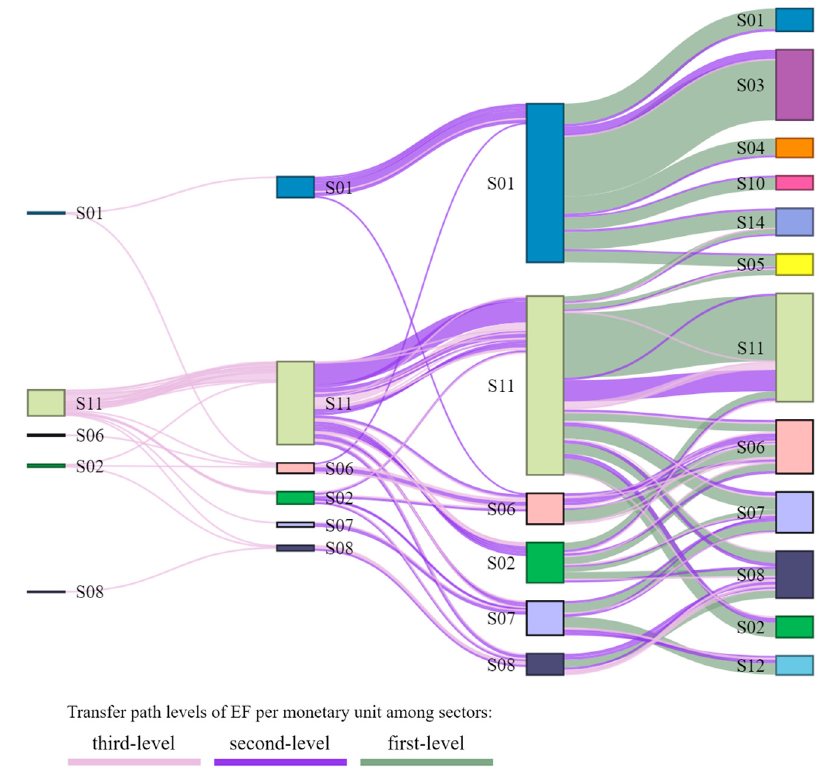
Figure 7. The key transfer path of China’s EF per monetary unit among sectors in 2010.